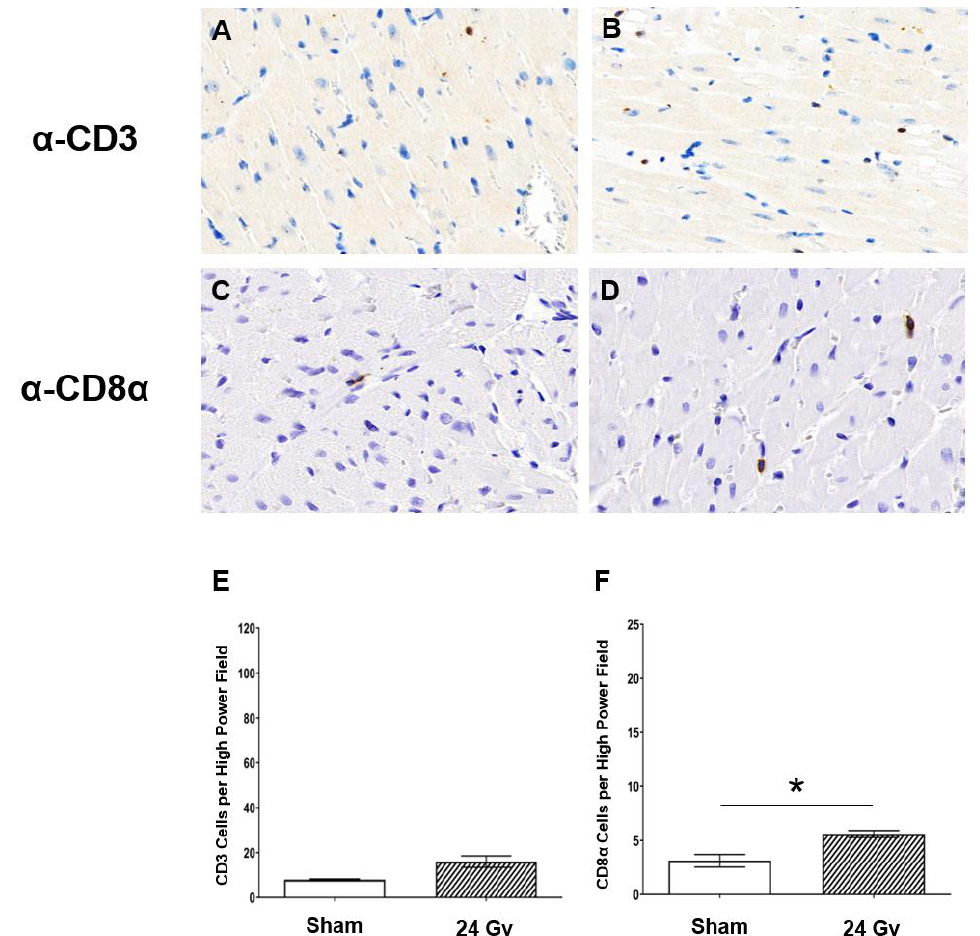
Figure 6. Irradiated SS WT male rat hearts display trends of increased T-cell infiltration compared to sham-treated rats, but have less T-cell infiltration than SS WT female rats. Adult SS WT male rats were administered either 24 Gy of localized cardiac radiation in one fraction or sham radiation. Representative images of CD3 staining in heart tissue of rats given either ( A ) sham or ( B ) 24 Gy RT. Representative images of CD8 α staining in heart tissue of rats given either sham ( C ) or 24 Gy RT ( D ). T-cell population staining was quantified as the average number of cells per high-power field for CD3 ( E , p = 0.057 for sham versus 24 Gy) and CD8 α ( F ) stained cell populations (values are means ± SEM; n = 3–5 / group, * p < 0.01). Values are means ± SEM; n = 3–5 rats / group, * p < 0.05. All images are at 40× magnification.